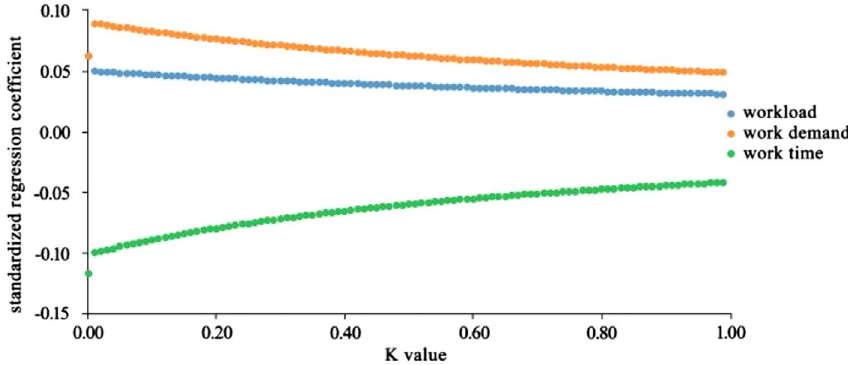
Figure 1. Ridge trace diagram of workload and its dimensions on miners’ unsafe state.